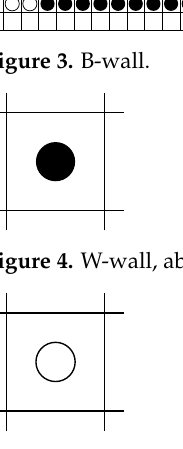
Figure 5. B-wall, abbrev.